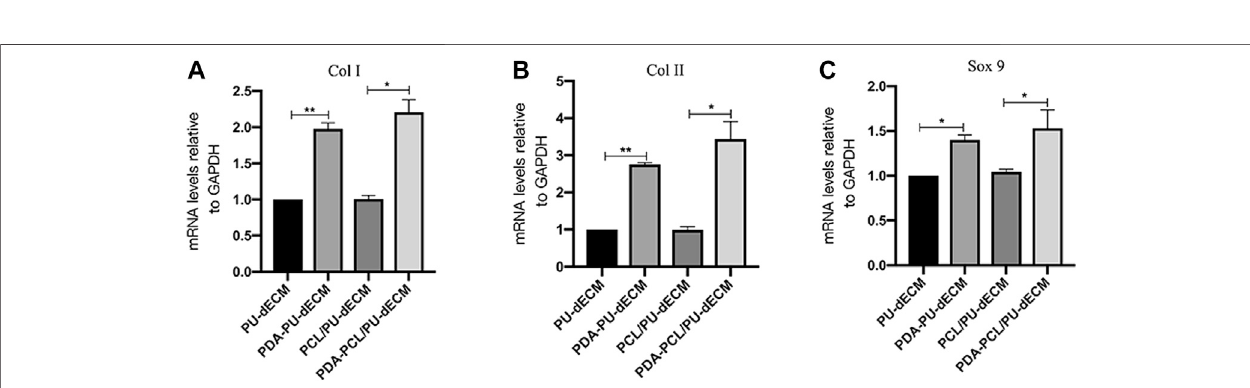
FIGURE5| Genesexpression ofthe scaffolds. (A) COL I , (B) COL II, and (C) SOX 9 .(*Comparison betweenoriginalgroupsand modi fi ed groups, n (cid:2) 3,* p < 0.05, ** p < 0.01).